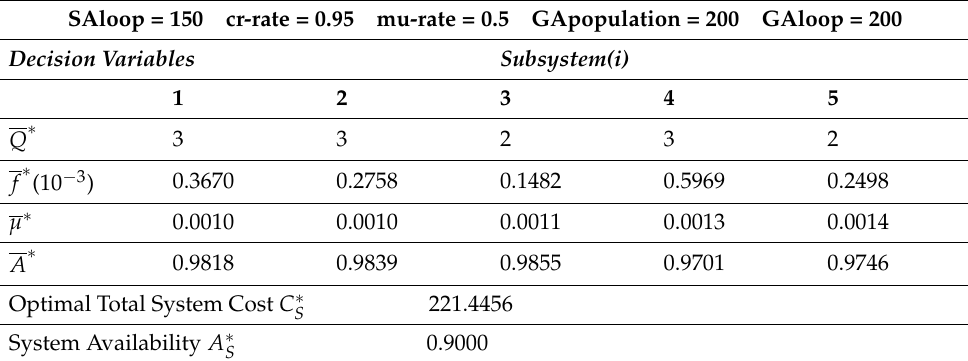
Figure 21. The convergence graph of the n -stage mixed system by utilizing the NESA-MGA com- bined method. Table 42. Optimal Solutions obtained by NESA–MGA for the n -stage mixed